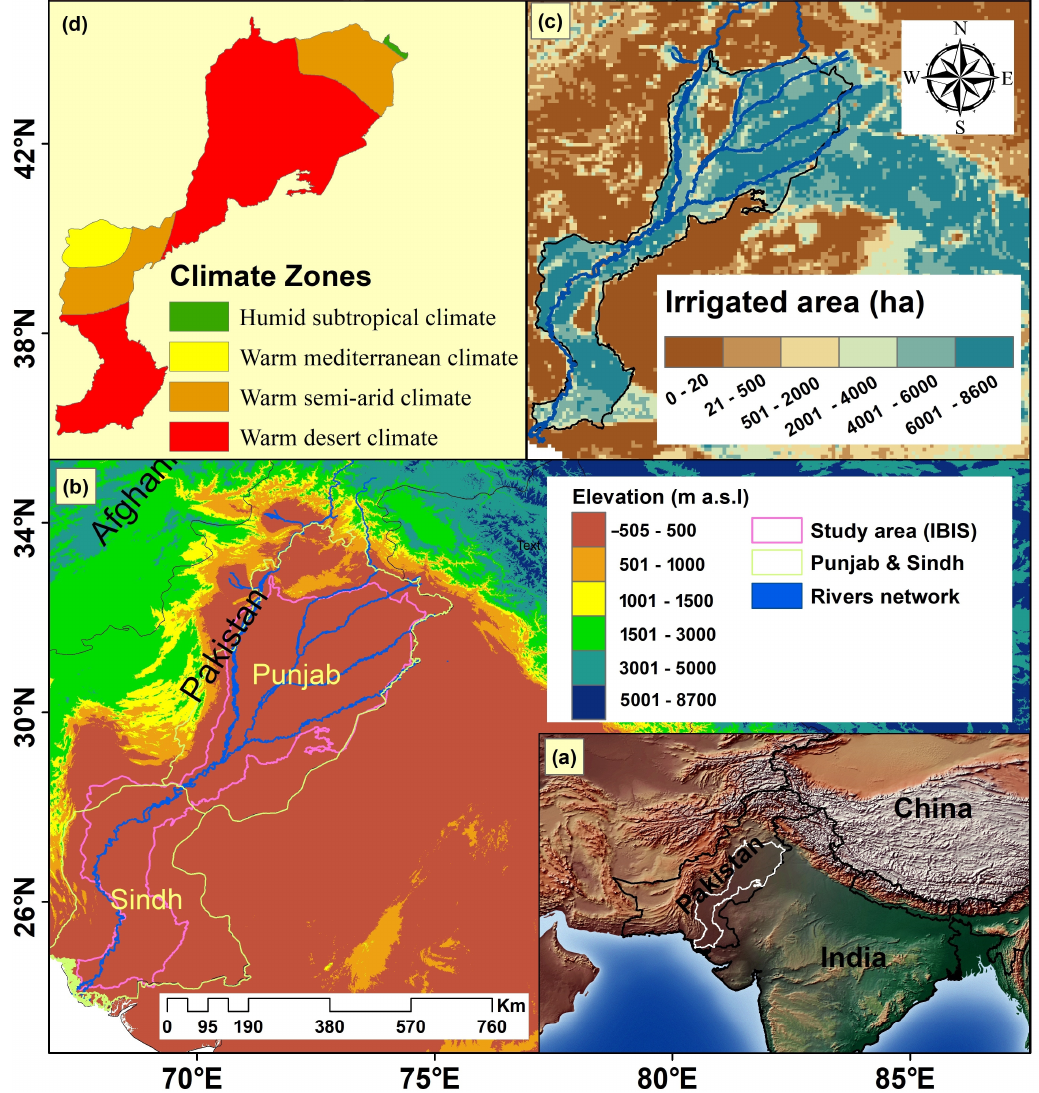
Figure 1. Illustration of the geographic location using the Natural Earth dataset for the IBIS ( a ) accompanied by the surface elevation ( b ), the irrigated land area by Siebert et al. [89] ( c ), and the Koppen Geiger Climate Classification-based climatic zones of the IBIS ( d ).